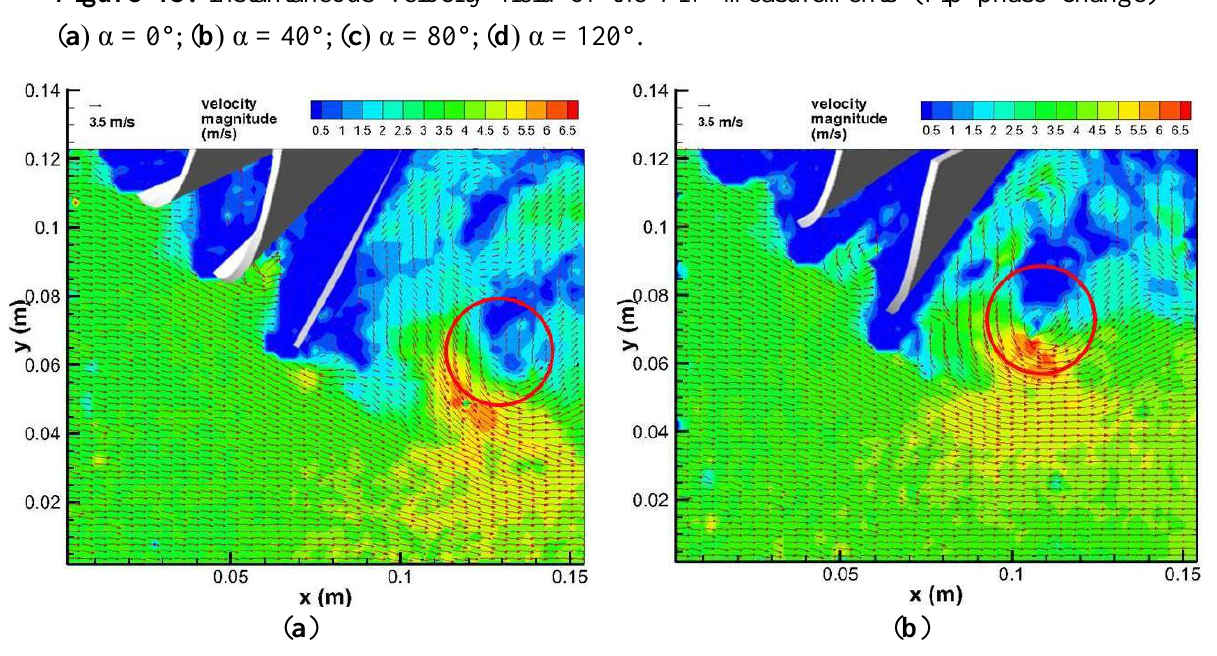
Figure 13. Instantaneous velocity field of the PIV measurements (Tip phase